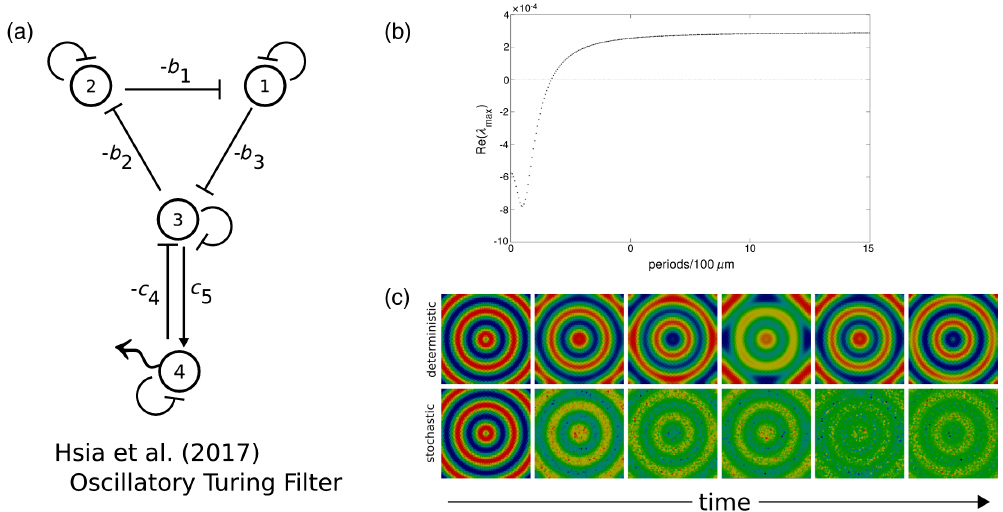
FIG. 14. (a) Design for synthetic genetic Turing network proposed by Hsia et al. in Ref. [40]. The system is formed by an unstable oscillatory subnetwork (species 1, 2, and 3) quenched by a single diffusible molecule (species 4). (b) Dispersion relationship characteristic of an oscillatory Turing filter. (c) Oscillatory amplification of a prepattern persists over time under deterministic dynamics (top), but it is degraded and lost after a few periods under stochastic dynamics